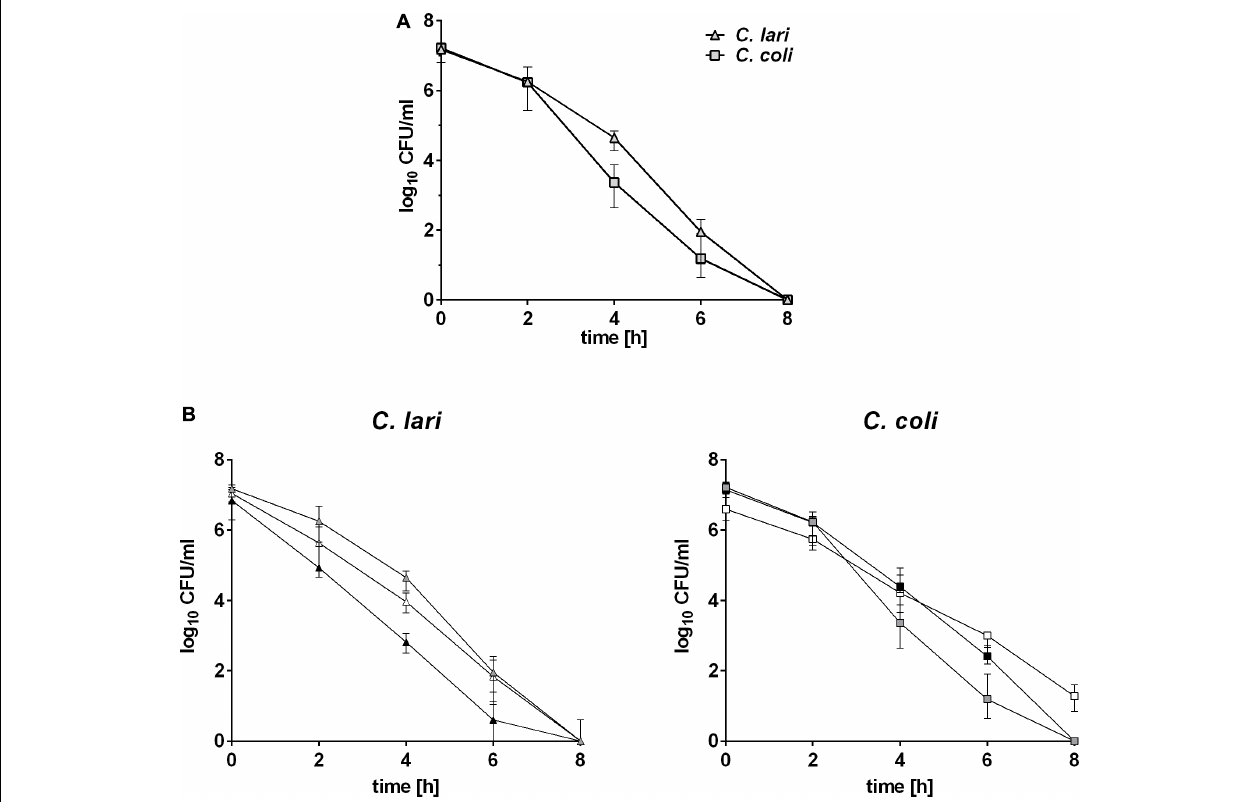
FIGURE 1 | Survival abilities of C. coli and C. lari at 46 ◦ C. Bacterial cultures of approximately 7 log 10 CFU/ml were incubated at 46 ◦ C and cell counts determined at indicated time points. Data were shown for (A) reference strains and (B) wild type strains of C. coli and C. lari as median ± interquartile range of three biological replicates. Gray: sequenced strains, white: first field strain, and black: second field strain.